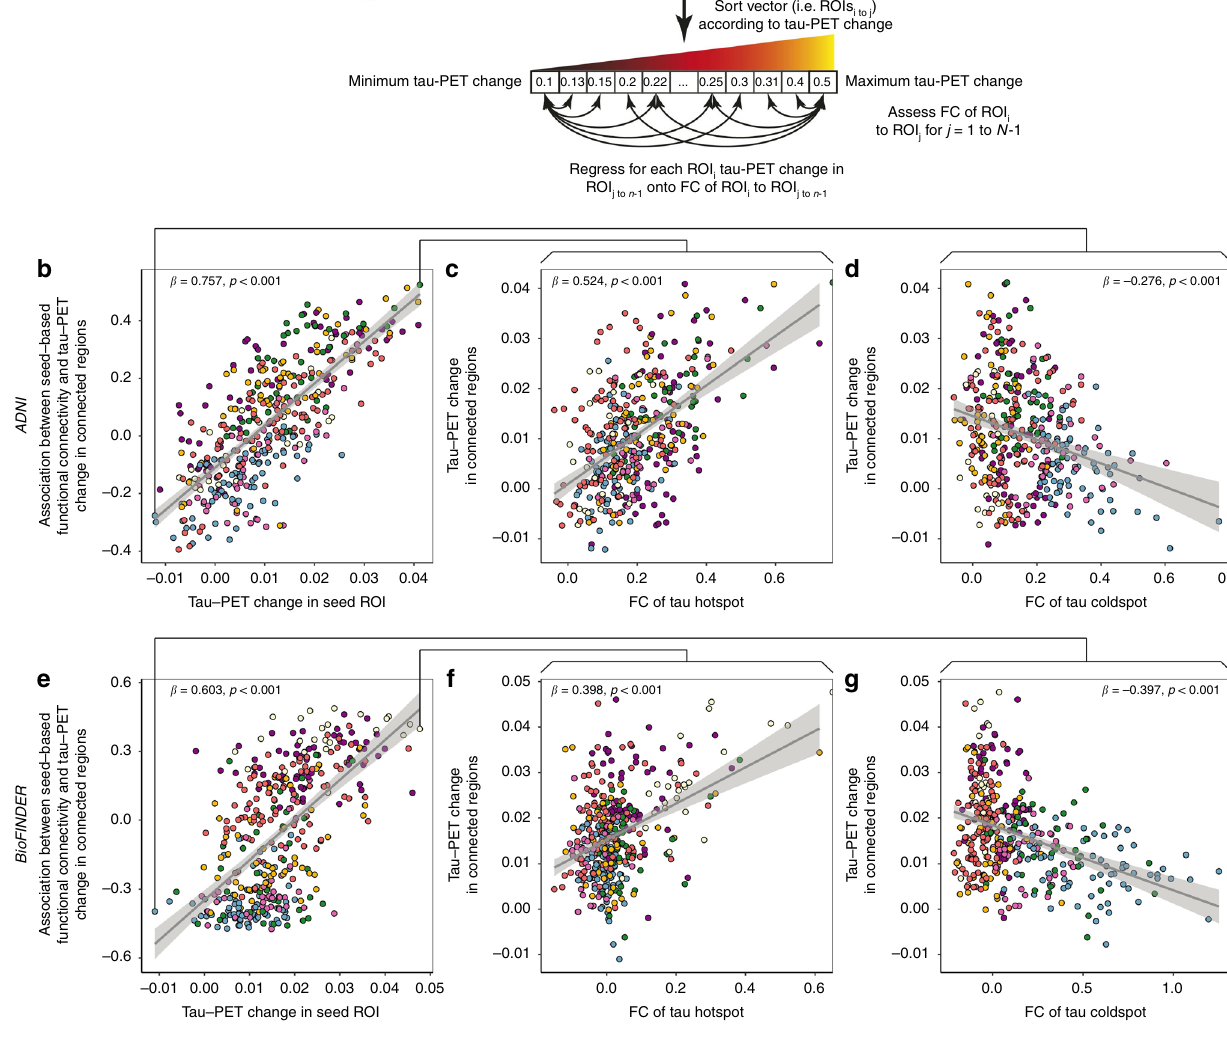
Fig. 6 Associations between functional connectivity and tau-PET change. a Pipeline for testing the association between group-average functional connectivity and annual tau-PET change in the 53 A β + from ADNI and 41 A β + subjects from BioFINDER. subjects. For both ADNI ( b ) and BioFINDER ( e ), we plotted the association between annual tau-PET change of a seed-ROI ( x -axis) and the regression-derived association between its ’ functional connectivity to target regions and tau-PET change in the respective target regions ( y -axis). Positive y-values indicate that higher FC to target regions is associated with higher annual tau-PET change, while negative y-values indicate that higher FC to target regions is associated with lower annual tau-PET changes. Illustration of the association between seed-based functional connectivity ( x -axis) and annual tau-PET change in connected regions ( y -axis) for ROIs with maximum (ADNI: c; BioFINDER: f) and minimum (ADNI: d; BioFINDER: g) annual tau-PET change. Linear model fi ts are indicated together with 95% con fi dence intervals. Source data are provided in a Source data fi